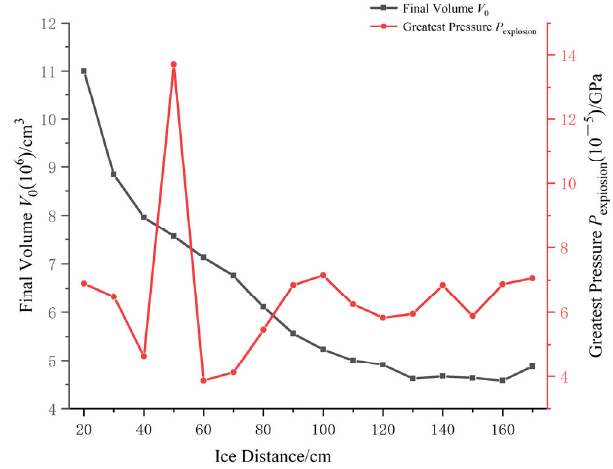
Figure 10. The relationship between ice distance, final volume, and final maximum pressure.